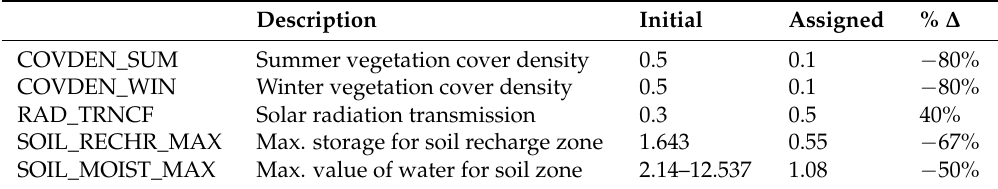
Table 1. Initial and assigned model parameter values for forest cover reduction analysis.